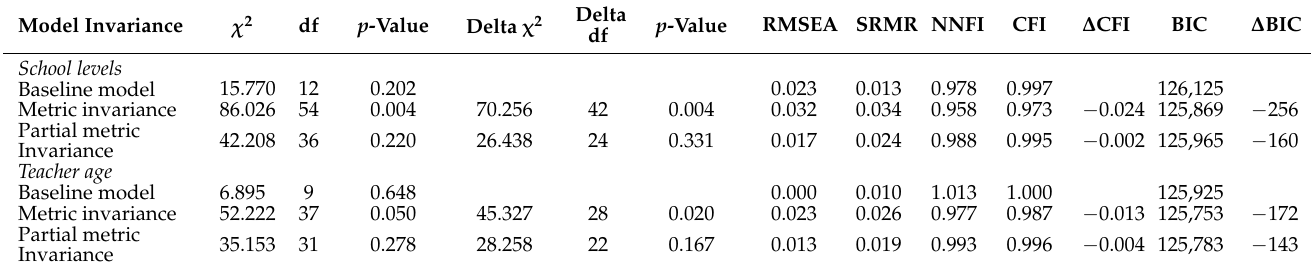
Table 6. Multi-group path analysis of Model